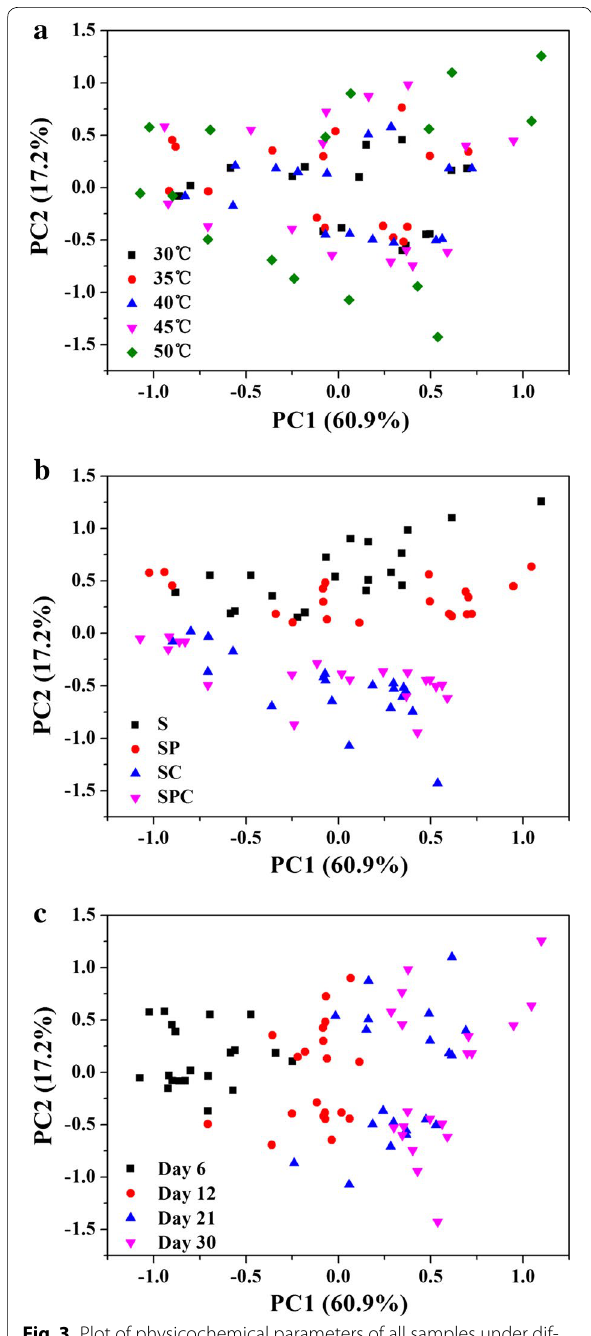
Fig. 3 Plot of physicochemical parameters of all samples under dif- ferent temperature ( a ), mineral composition ( b ) and stages ( c ) using principal component analysis